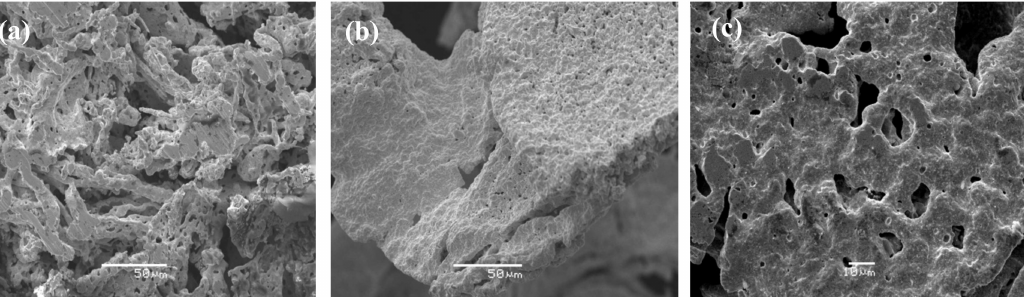
Figure 10. SEM images for the different (AuX n ) n samples: ( a ) AuCl, ( b ) AuCl 3 , and ( c ) Au(C 6 F 5 ).